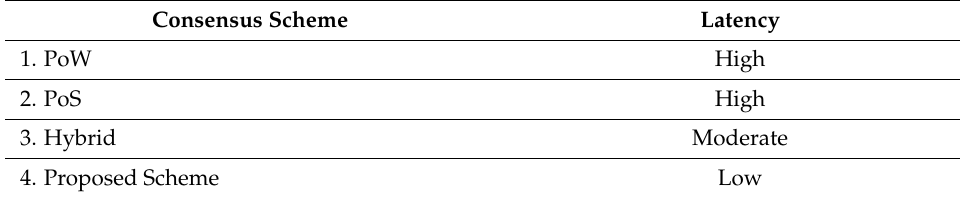
Table 2. Comparative analysis of results.